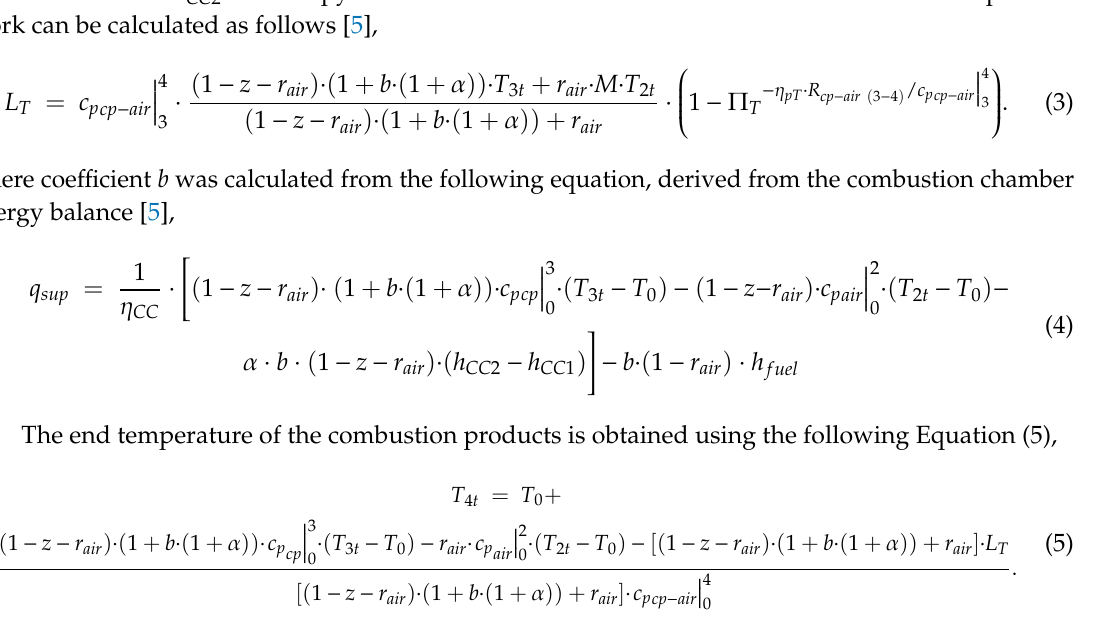
Figure 2. Basic humidified Brayton cycle with cooling air extraction at the compressor exhaust (where C is compressor, CC combustion chamber and T is gas turbine, point 0 refers to ambient conditions, point 1—conditions at the compressor inlet, point 2—conditions at the compressor outlet or combustion chamber inlet, point 3—combustion chamber outlet or gas turbine inlet, point 4—gas turbine outlet).